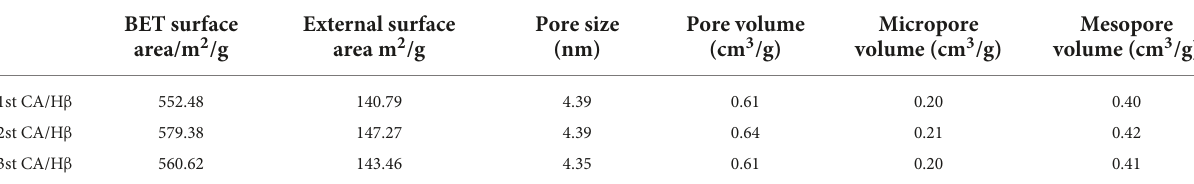
TABLE 2 Surface properties of